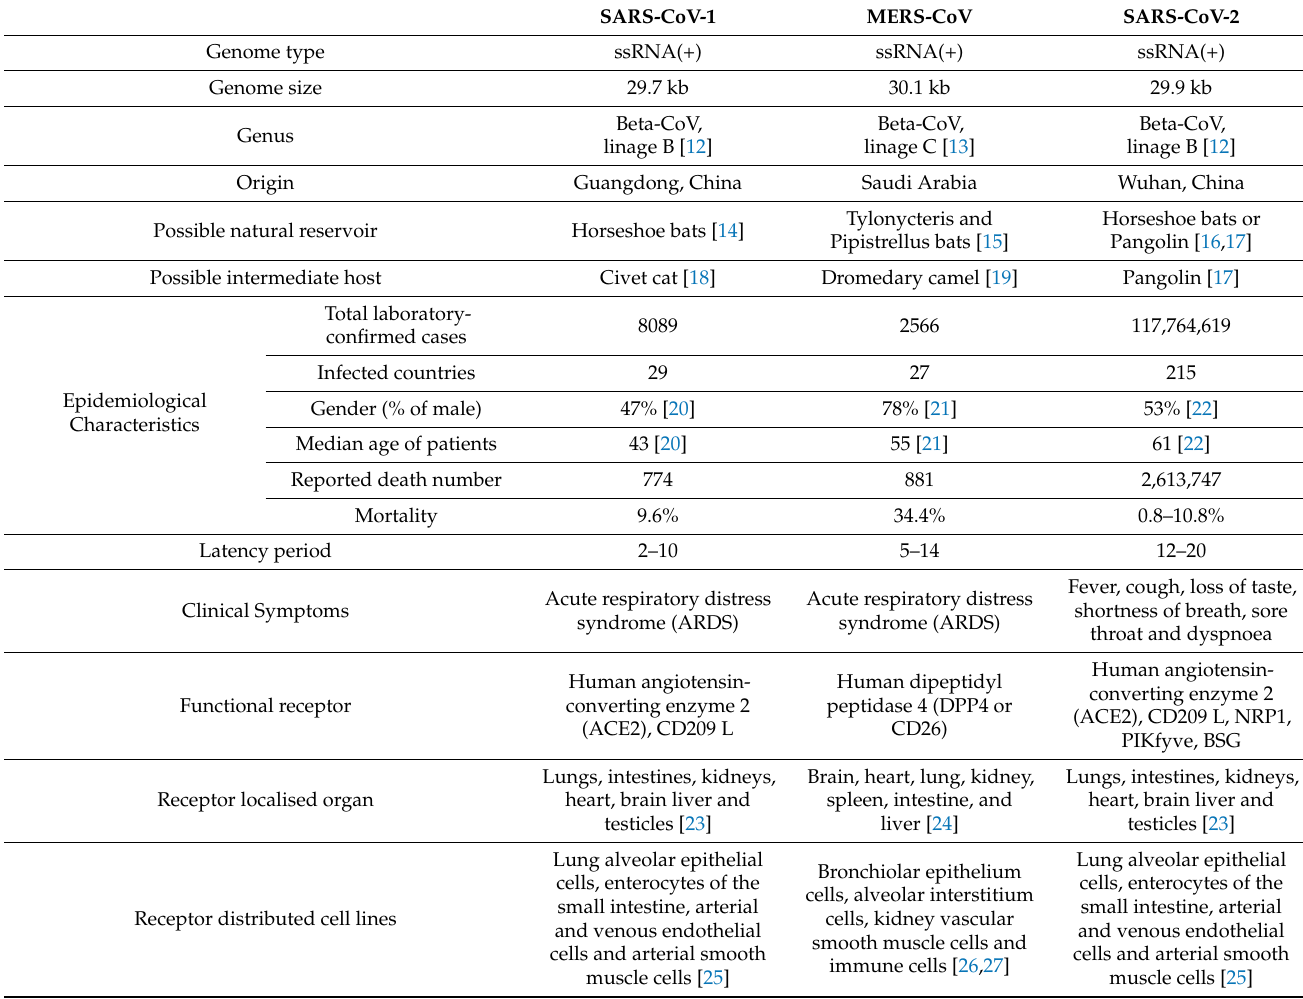
Table 1. Biological and Epidemiological Characteristics of CoVs (10 Mar